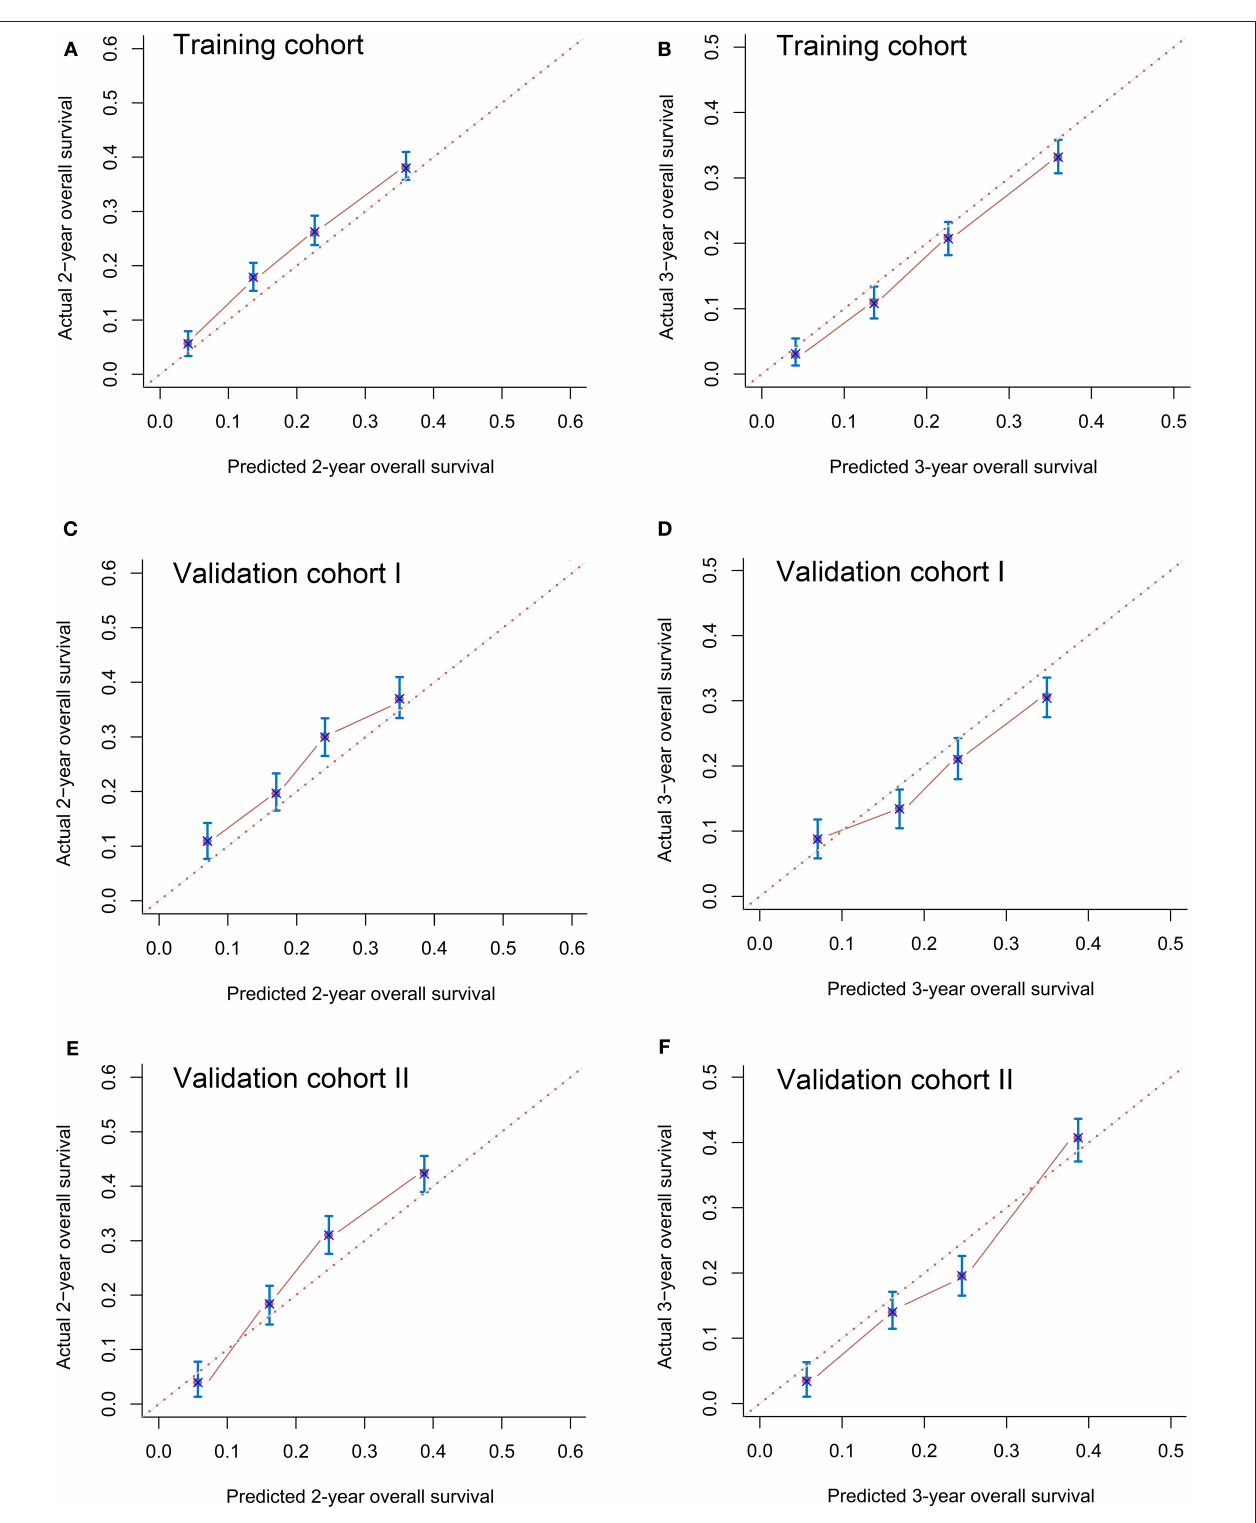
FIGURE 4 | Calibration curves for predicting 2-years (A) and 3-years (B) overall survival in the training cohort, 2-years (C) and 3-years (D) overall survival in validation cohort I and 2-years (E) and 3-years (F) overall survival in validation cohort II.